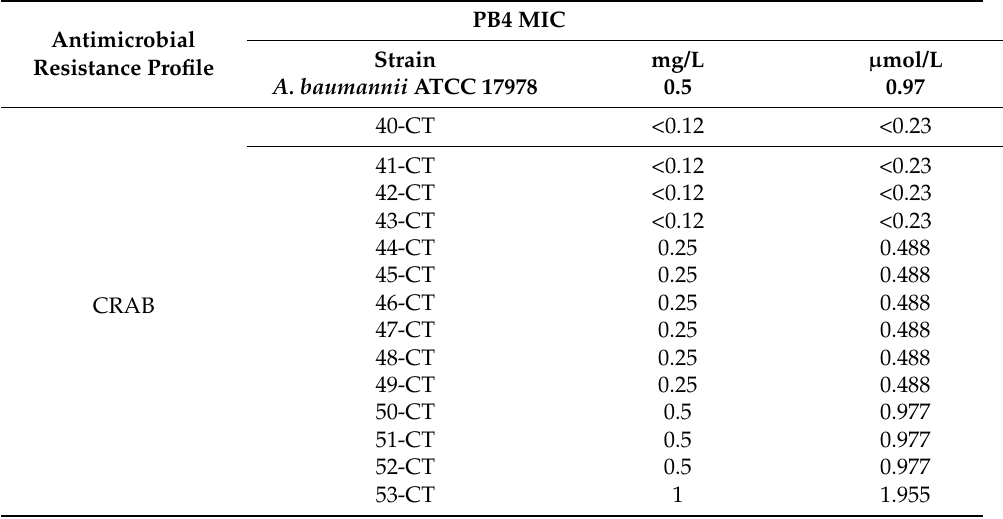
Table 4. Activity of PB4 on A. baumannii ATCC 17978 control strain and 14 CRAB clinical strains.